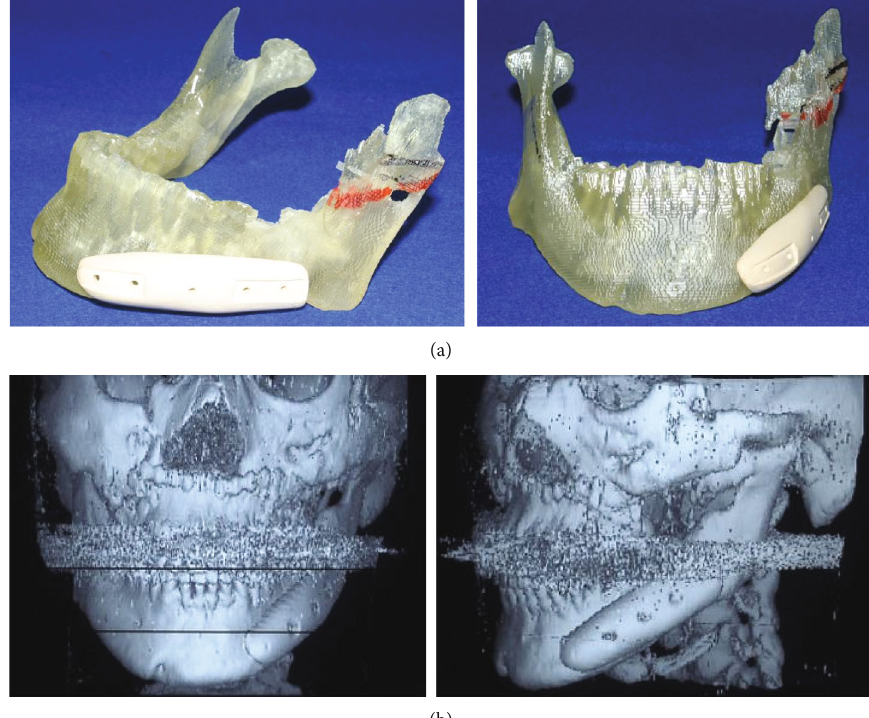
Figure 5: HAP-TCP blocks for onlay grafting on three-dimensional model (a) and cephalic CT images after onlay grafting of HAP-TCP block